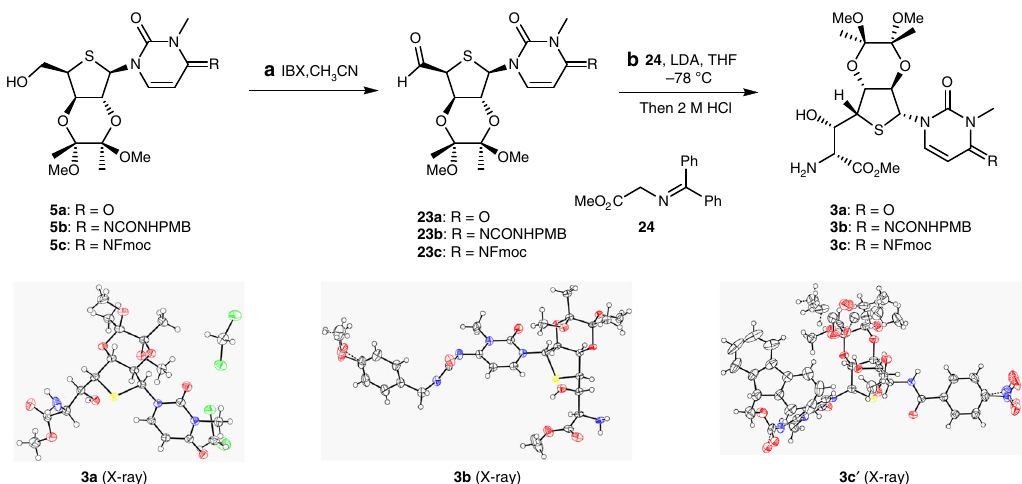
Fig. 4 Synthesis of fragments 3a – c and X-ray crystal-structure diagrams of 3a , 3b , and 3c' . Reagents and conditions: a IBX (2.0 equiv), CH 3 CN, 55 °C, 5 h; b 24 (1.1 equiv), LDA (1.1 equiv), THF, − 78 °C, then 2 M HCl, 3a : 86% (d.r. 4:1), 3b : 83% (d.r. 3:1), 3c : 75% (d.r. 3:1), (over 2 steps). IBX 2-iodoxybenzoic acid, LDA lithium diisopropylamide